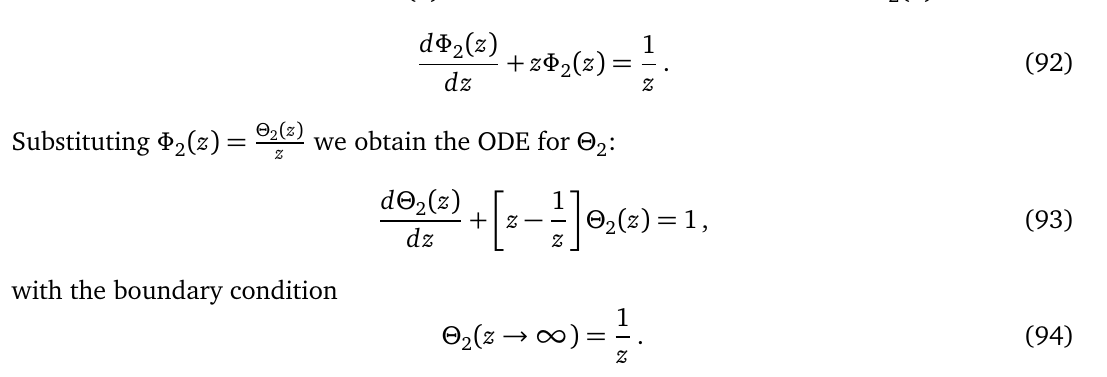
( z )] (blue curve). Right: Re [ σ R 2